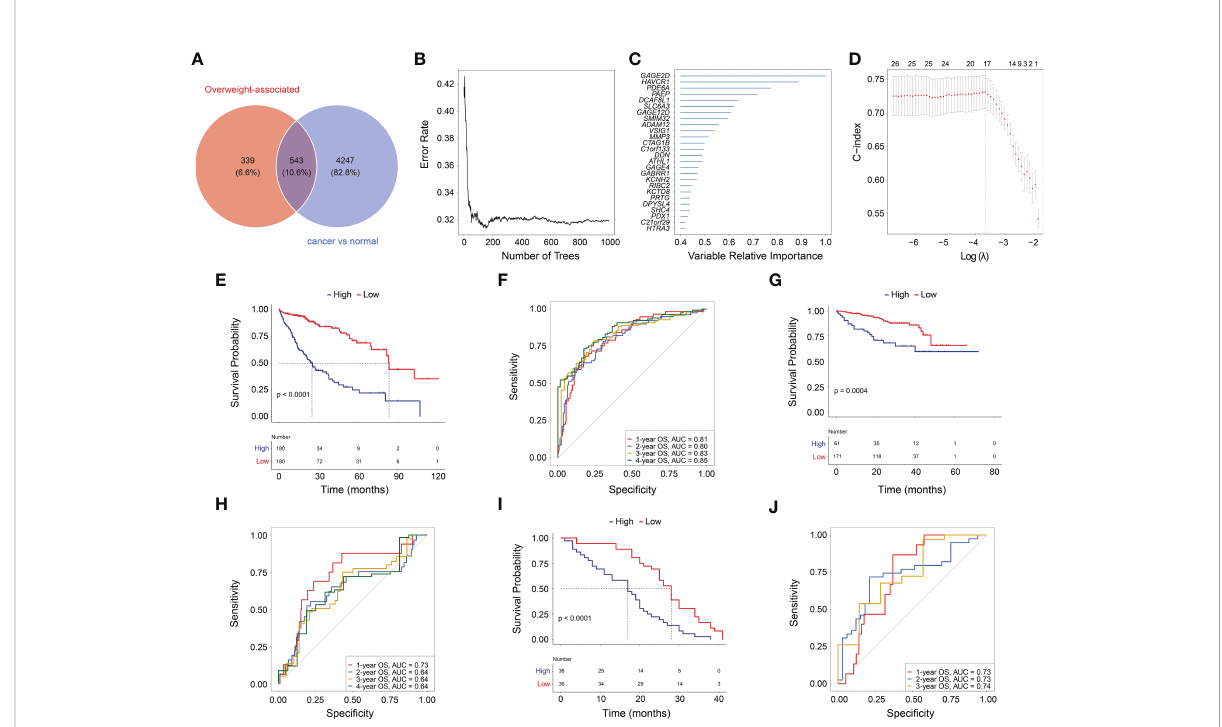
FIGURE 3 Machine learning for construction of overweight-associated gene (OAG) signature. (A) Overlapping of overweight-associated genes and differentially expressed genes between cancer and normal samples. (B) The random forest algorithm for identi fi cation of key genes correlated with overall survival (OS) in HCC. (C) The evaluation of the importance of selected OAGs. (D) The least absolute shrinkage and selection operator (LASSO) Cox regression analysis for determining an OAG signature and corresponding scoring system. (E) Kaplan – Meier curve analysis between high and low OAG score in TCGA-HCC cohort. (F) The receiver operating characteristic (ROC) curve analysis of OAG signature in prognosis prediction in TCGA-HCC cohort. (G) Kaplan – Meier curve analysis between high and low OAG score in ICGC-LIHC-JP cohort. (H) The ROC curve analysis of OAG signature in prognosis prediction in ICGC-LIHC-JP cohort. (I) Kaplan – Meier curve analysis between high and low OAG scores in GSE54236 dataset. (J) The ROC curve analysis of OAG signature in prognosis prediction in GSE54236 dataset. HCC, hepatocellular